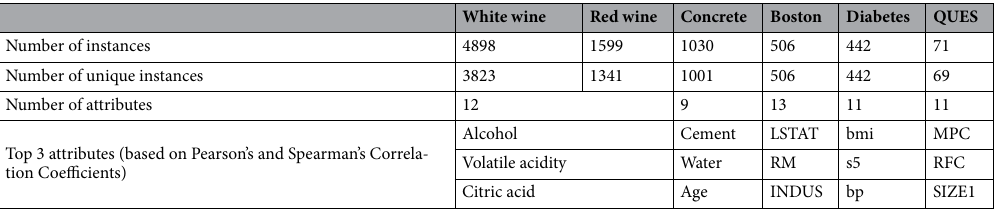
Table 5. Dataset